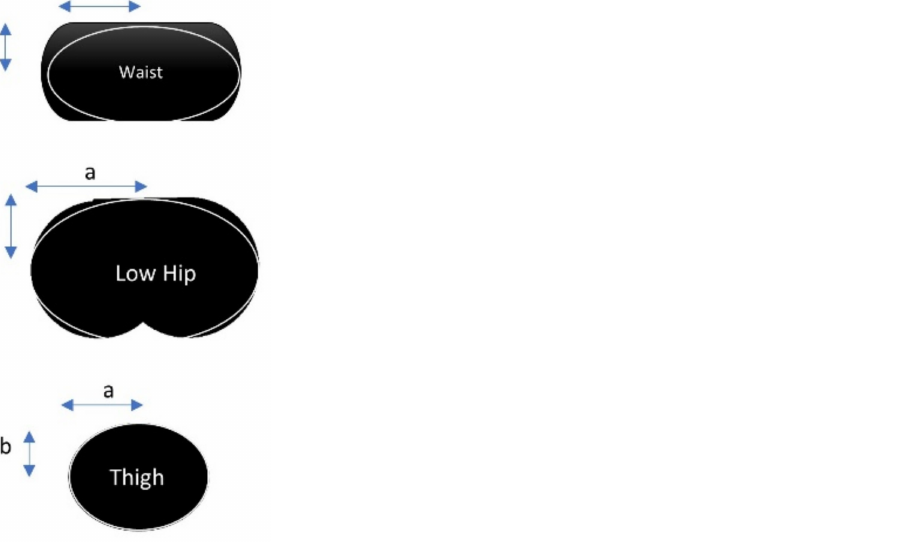
Figure 10. Approximated area of the measurements. The waist, lower hip and thigh areas are considered to be ellipses.